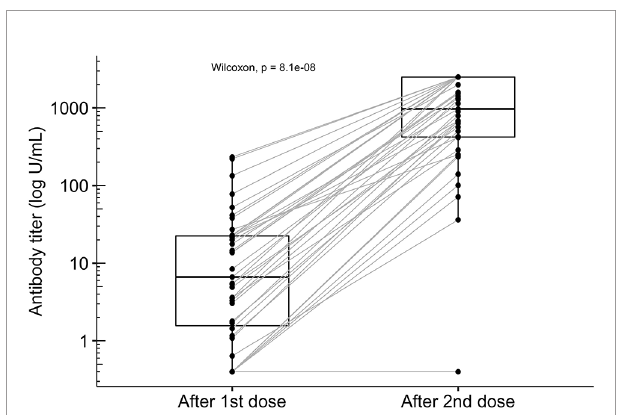
FIGURE 1 | Antibody titers in 39 peritoneal dialysis patients after the fi rst and the second dose of the mRNA-1273 vaccine. Seropositivity was detected in 38 of 39 peritoneal dialysis patients (circles). Antibody titers increased signi fi cantly from a median of 6.62 U/mL (IQR 1.57-22.5) four weeks after the fi rst dose to 968 U/mL (IQR 422.5-2500 U/mL) after the second dose (Wilcoxon matched pairs signed rank test, p = 8.057 x 10 -08 ). The technical upper limit of antibody detection was at 2500 U/mL and was reached in 11 patients (circles may